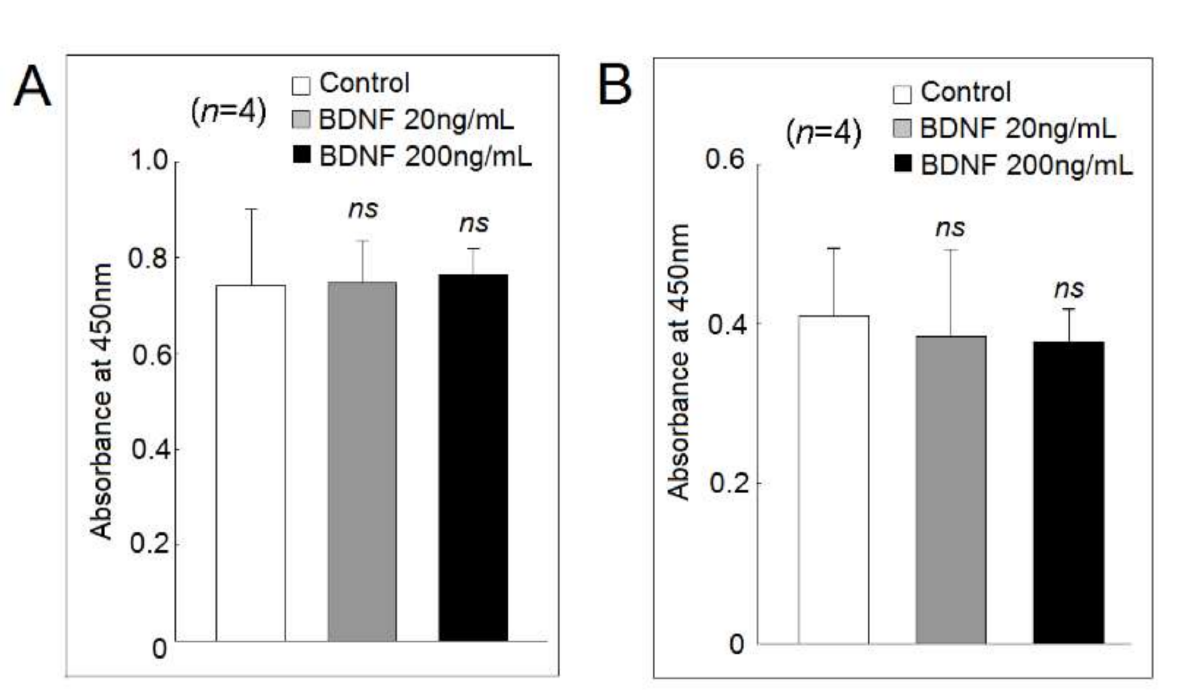
Figure 5. Effects of different concentrations of BDNF on ( A ) U937 cells and ( B ) differentiated macrophages viability and proliferation analyzed using the mitochondrial dehydrogenase cleavage assay (ns, not